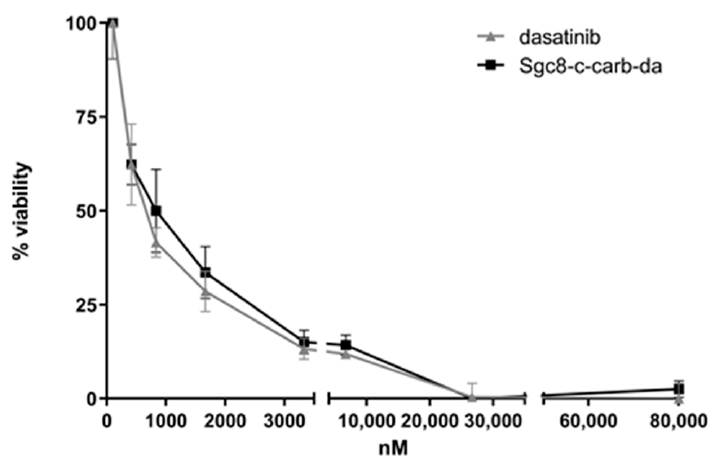
Figure 2. Doses-response curves for dasatinib and Sgc8-c-carb-da in A20 cells using the MTT method. Cytotoxicity was evaluated by MTT. Graph shows mean ± standard deviation (SD), n = 10 per condition. Table 2. Cytotoxic effects of dasatinib and Sgc8-c-carb-da against A20 cells, PTK7-positive CCRF- CEM, and negative U87 MG controls after different drug exposure times, expressed as IC 50 .